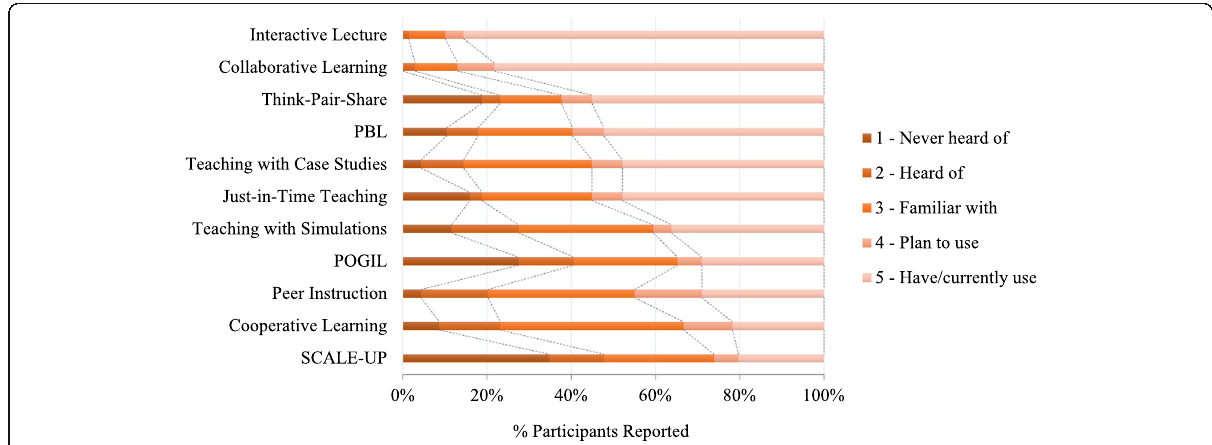
Fig. 2 Participant familiarity and use of EBIPs. Dotted lines emphasize differences in percentages for each